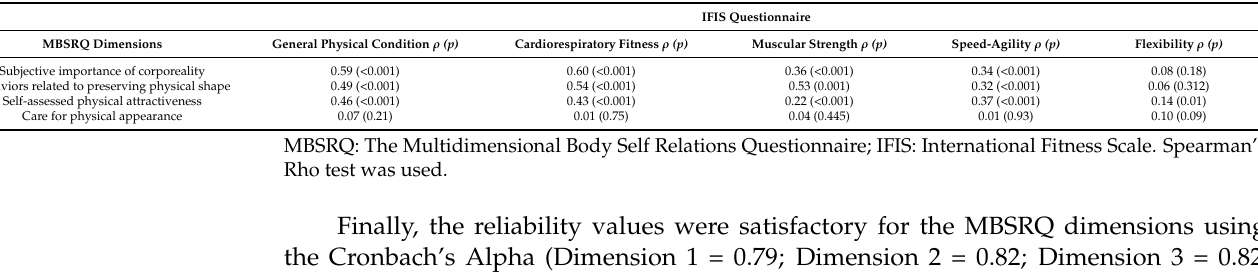
Table 5. Correlations between MBSRQ dimensions and the IFIS